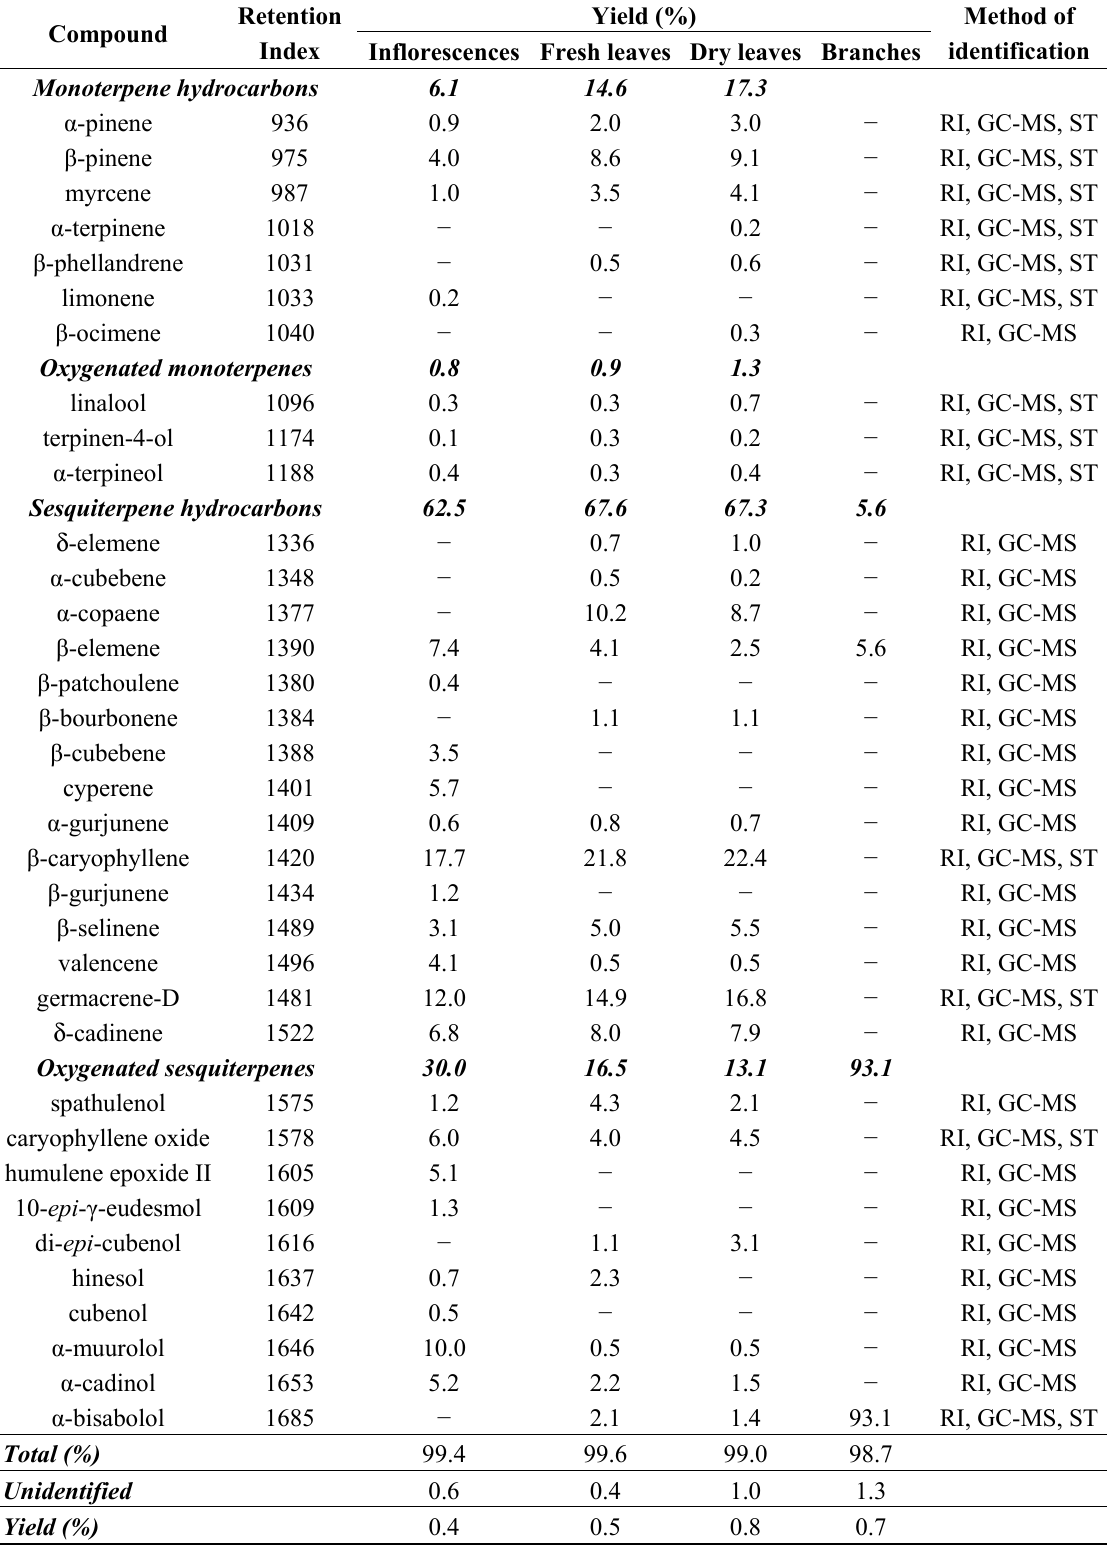
Yield (%) Method of